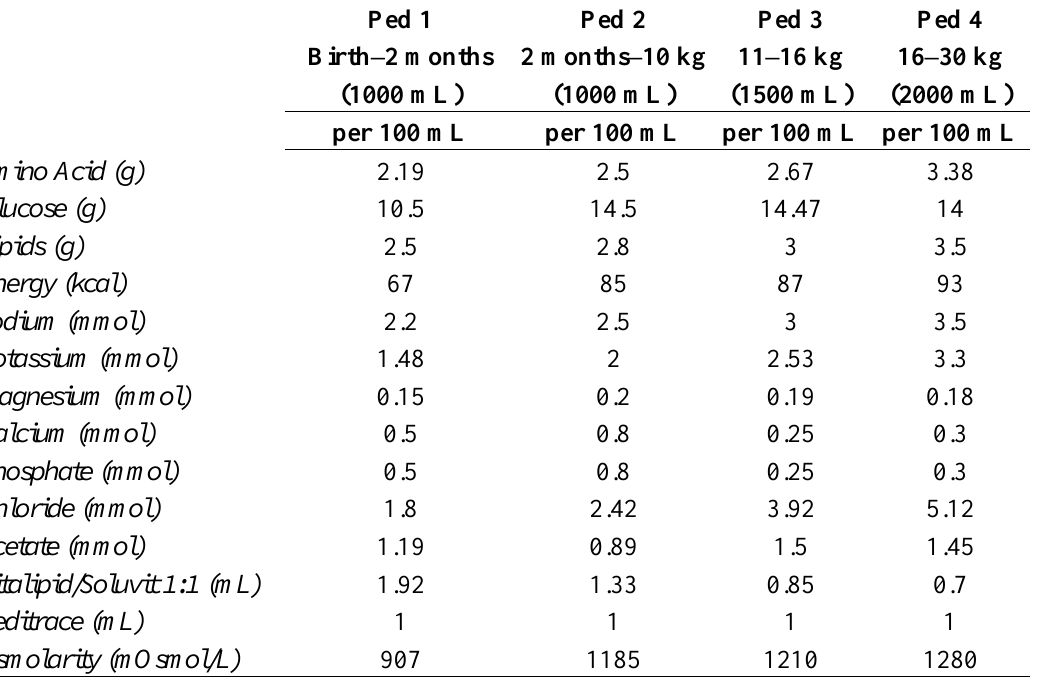
Table 2. Four AIO parenteral nutrition (PN)